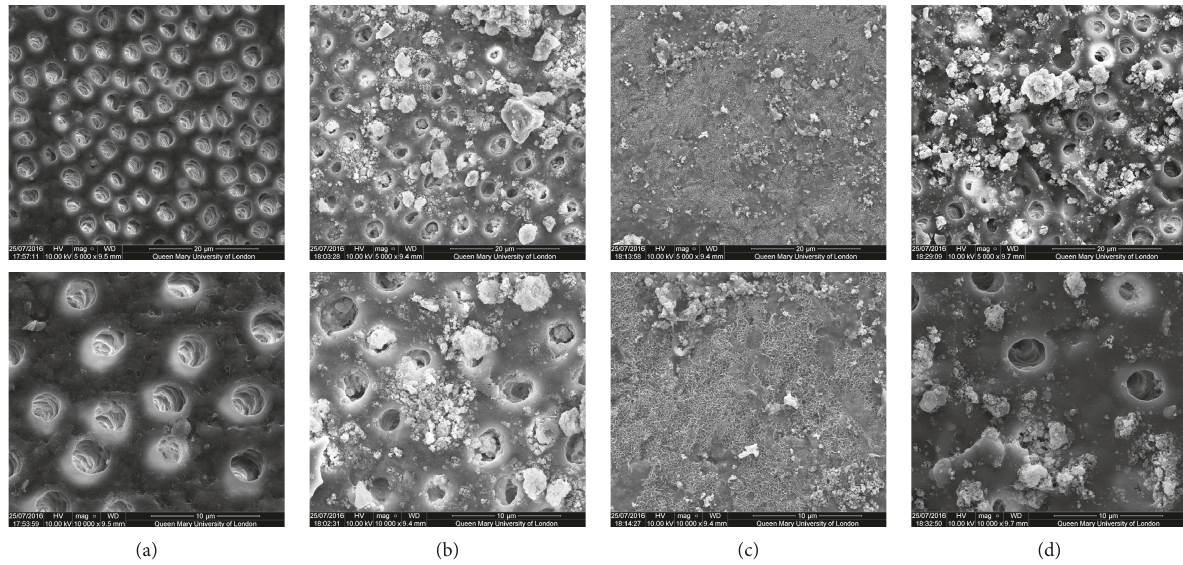
Figure 1: SEM images of the dentine surface morphology in disc 1 treated with a 45S5 glass-based toothpaste at 5000x (top) and 10000x (bottom) magnifications. (a) Control; (b) after brushing with a bioactive glass-based toothpaste; (c) after brushing with a bioactive glass- based toothpaste+artificial saliva immersion for 1 hour; (d) after brushing with a bioactive glass-based toothpaste+acid challenge with 6% citric